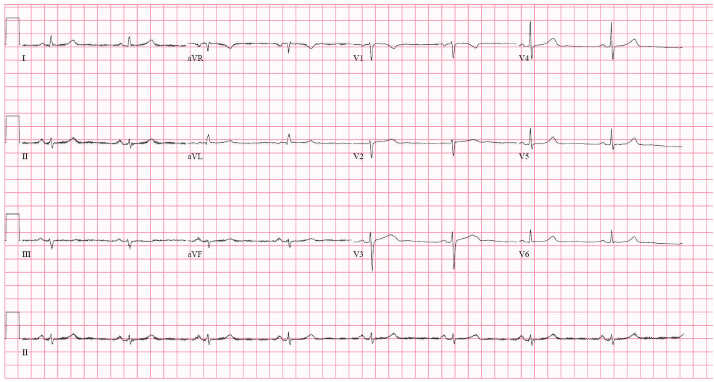
Figure 1: Baseline ECG obtained at initial consultation visit.